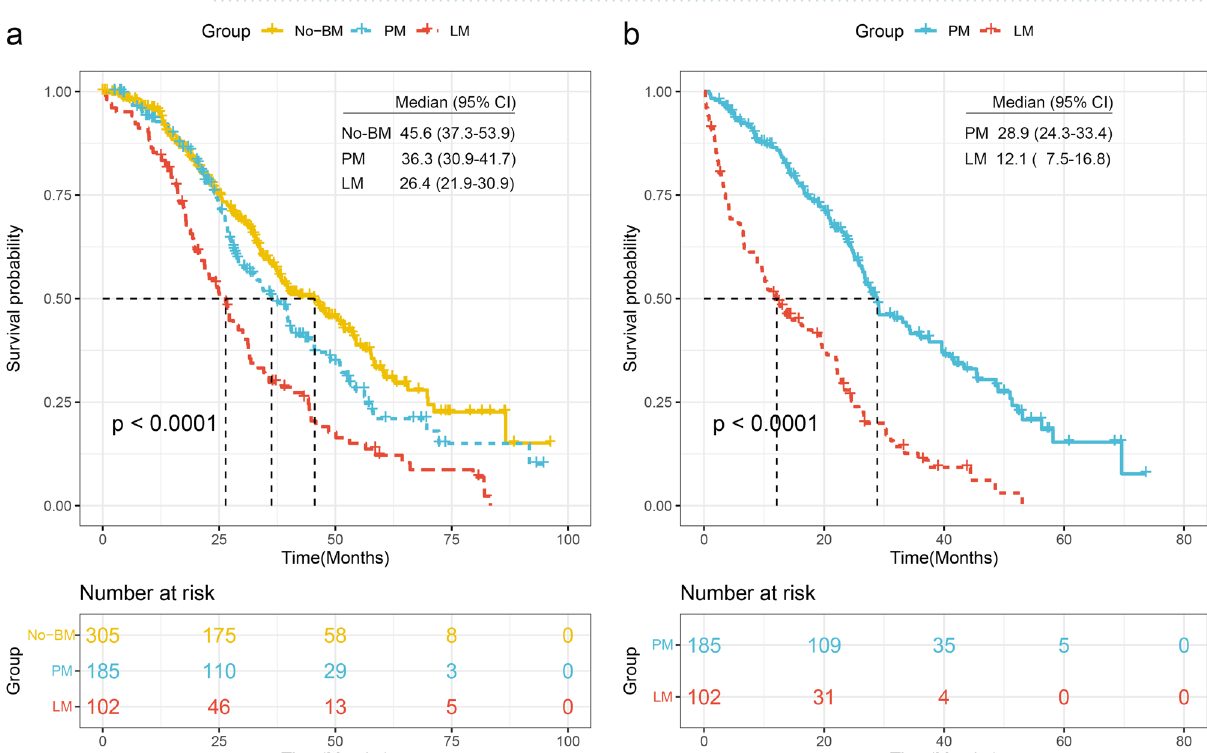
Figure 4. Metastatic sites. The summary of metastatic sites in patients with No-BM ( a ), PM ( b ) and LM ( c ).